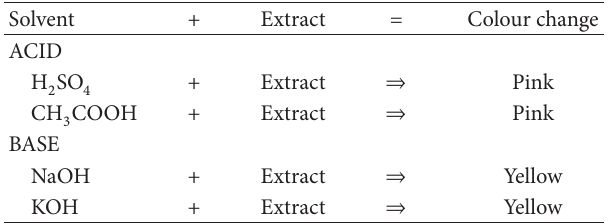
Table 6: Rose extract (cold extract) (initial color of extract,